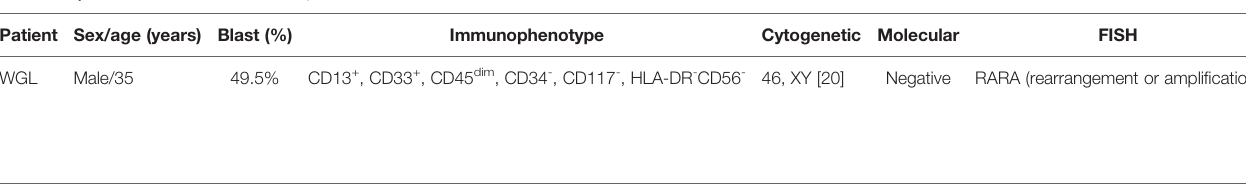
TABLE 1 | Clinical characteristics of the patient at